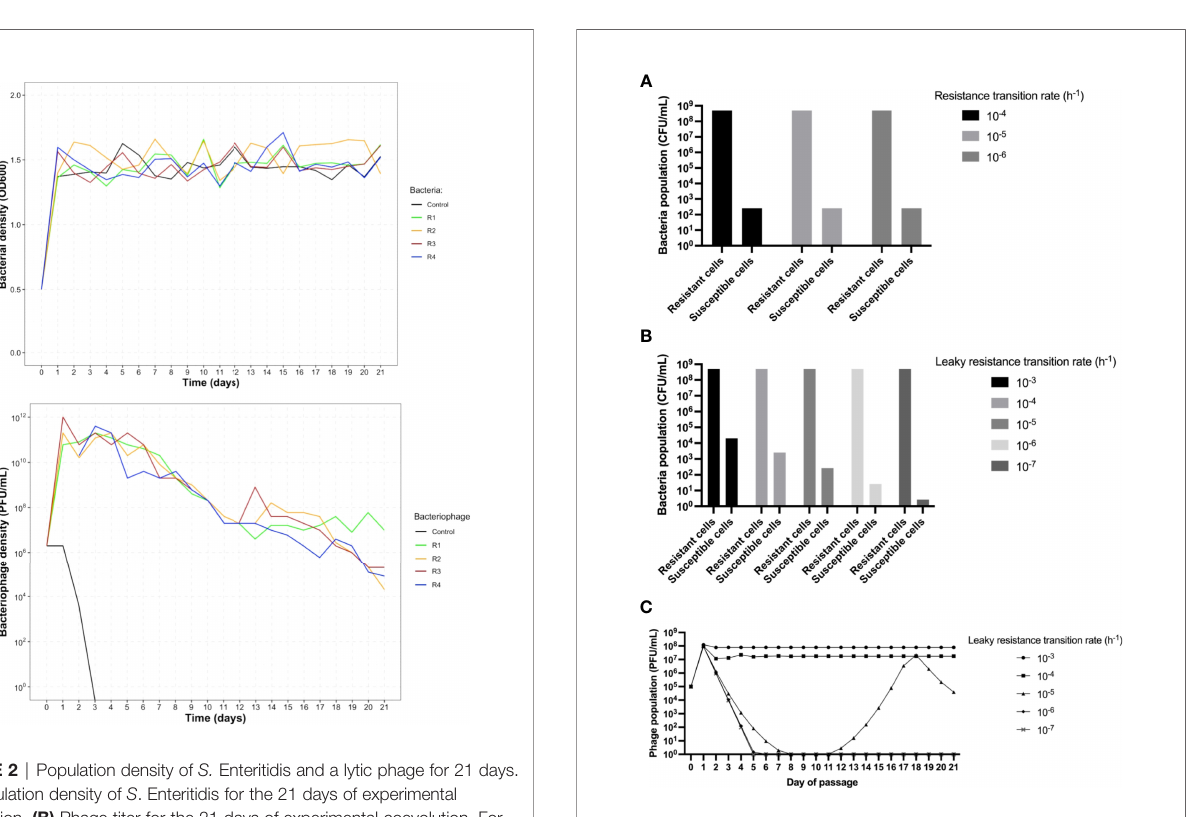
FIGURE 3 | Mathematical model and simulations. Computer simulation results for the changes in the densities of phage populations. Unless otherwise stated, the parameters used to simulate were: k=1, e= 5·10 -7 m g/ cell, v 2.0 h -1 , d =2·10-7 h -1 cell -1 , b =60 phages/cell. (A) Changes in phage densities after 23 hours when testing different values of m N . (B) Changes in phage densities after 23 hours when testing different values of m R . (C) Changes in phage densities for 21 days of serial passage (dilution factor of 0.01) when testing different values of m R